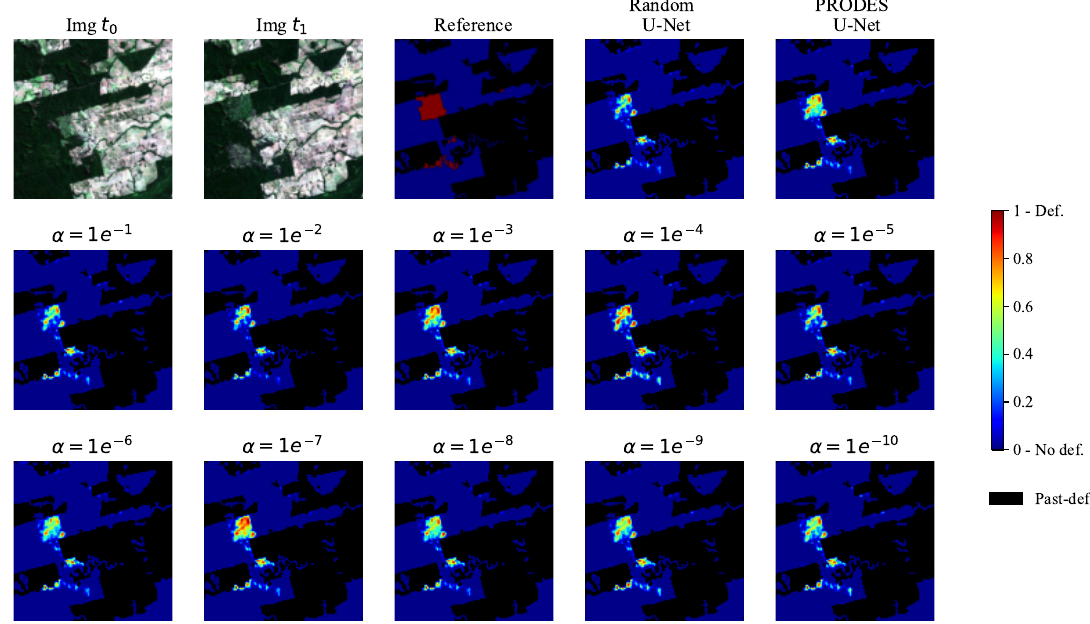
Figure 5. Visual example of a snip from the test set. The first line illustrates the RGB compositions of the snip in t 0 and t 1 , the class label map, and the baselines, using the U-Net architecture with two strategies of training sample selection. The second and third lines presents the probability maps varying the values of α in the Fully DB-VAE. Red and Blue color represent the highest and lowest probability of belonging to the deforestation class. Black color symbolize the past